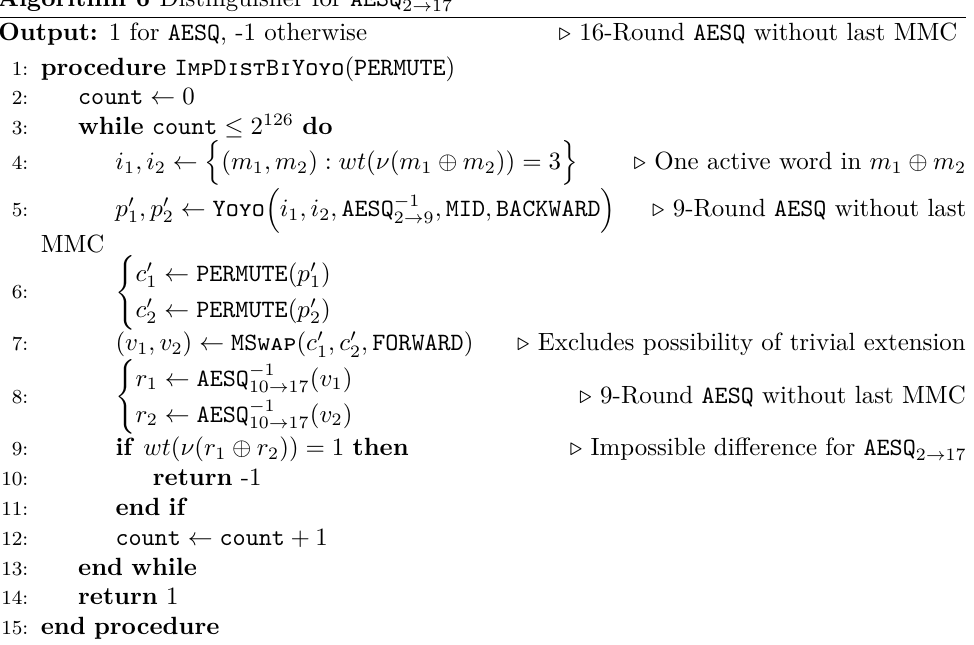
Algorithm 6 Distinguisher for AESQ